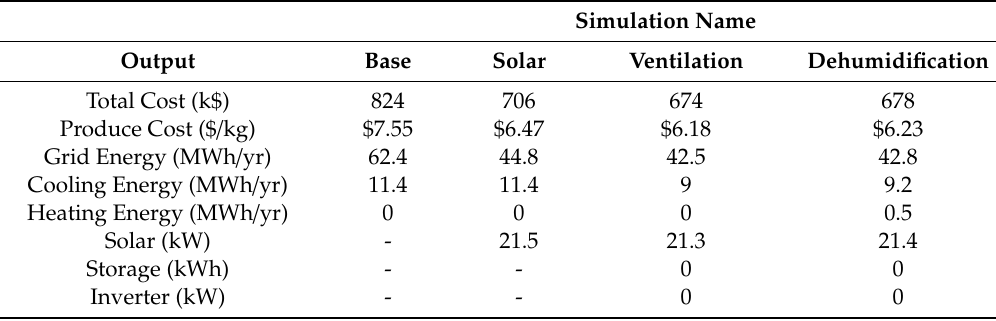
Table 4. Summary of results using a synthetic load profile in the FEWMORE model to analyze dispatchability of ventilation and dehumidification systems. Optimizing the dispatch of the ventilation system, in addition to adding a solar array, reduced costs by ~18%. Managing the demand of the dehumidification system, in addition to the ventilation system, did not provide any